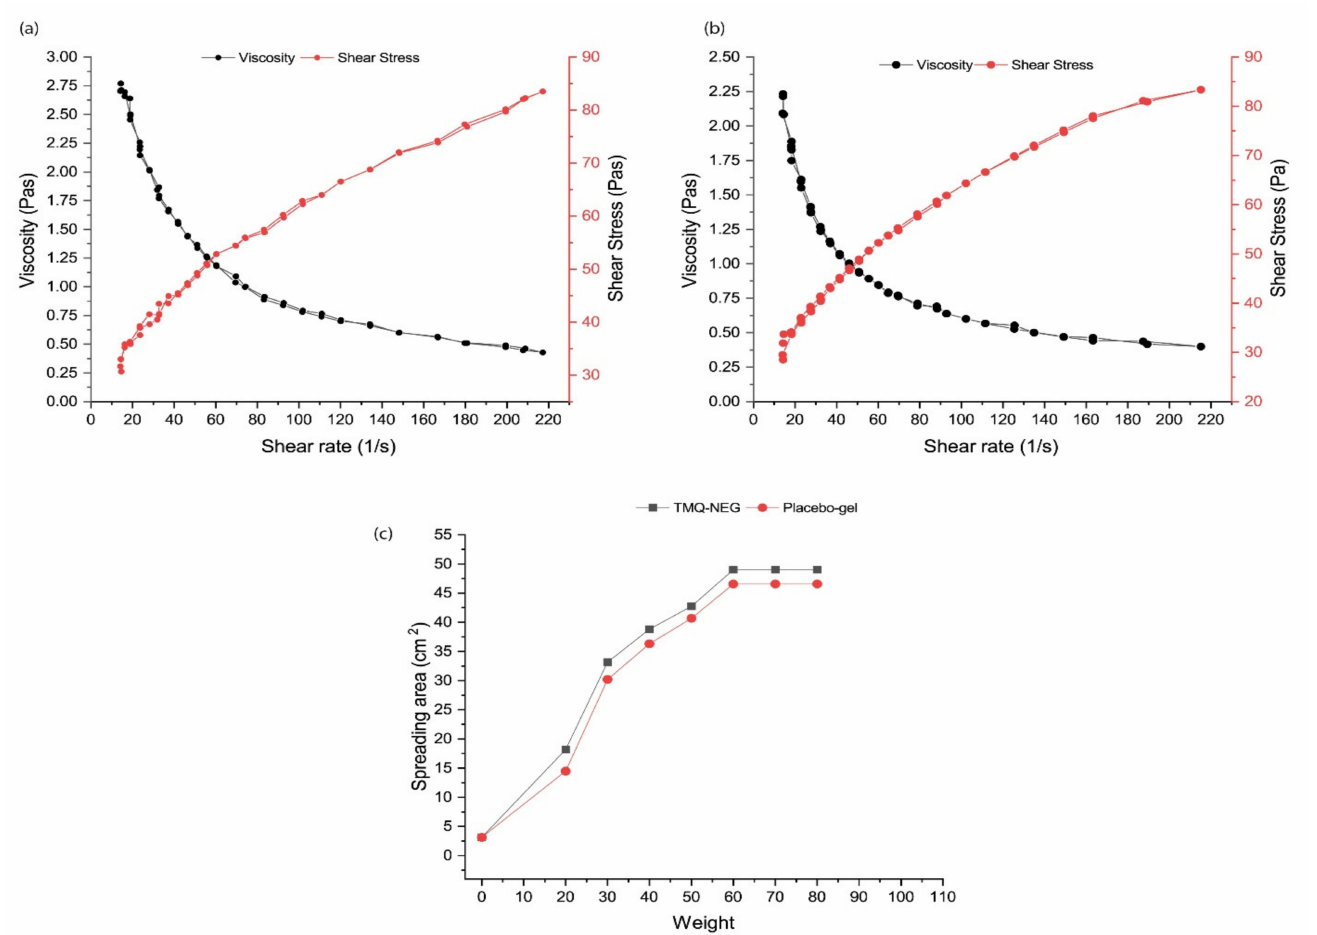
Figure 4. Rheology profile of gel ( a ) TMQ-NEG ( b ) Placebo gel ( c ) Spreadability behavior of TMQ-NEG and placebo